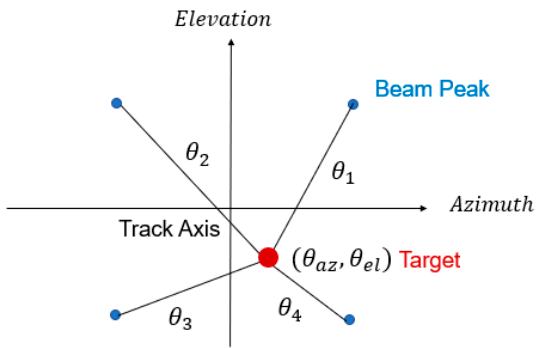
Figure 3. Gain-weighted direction vectors and the target.